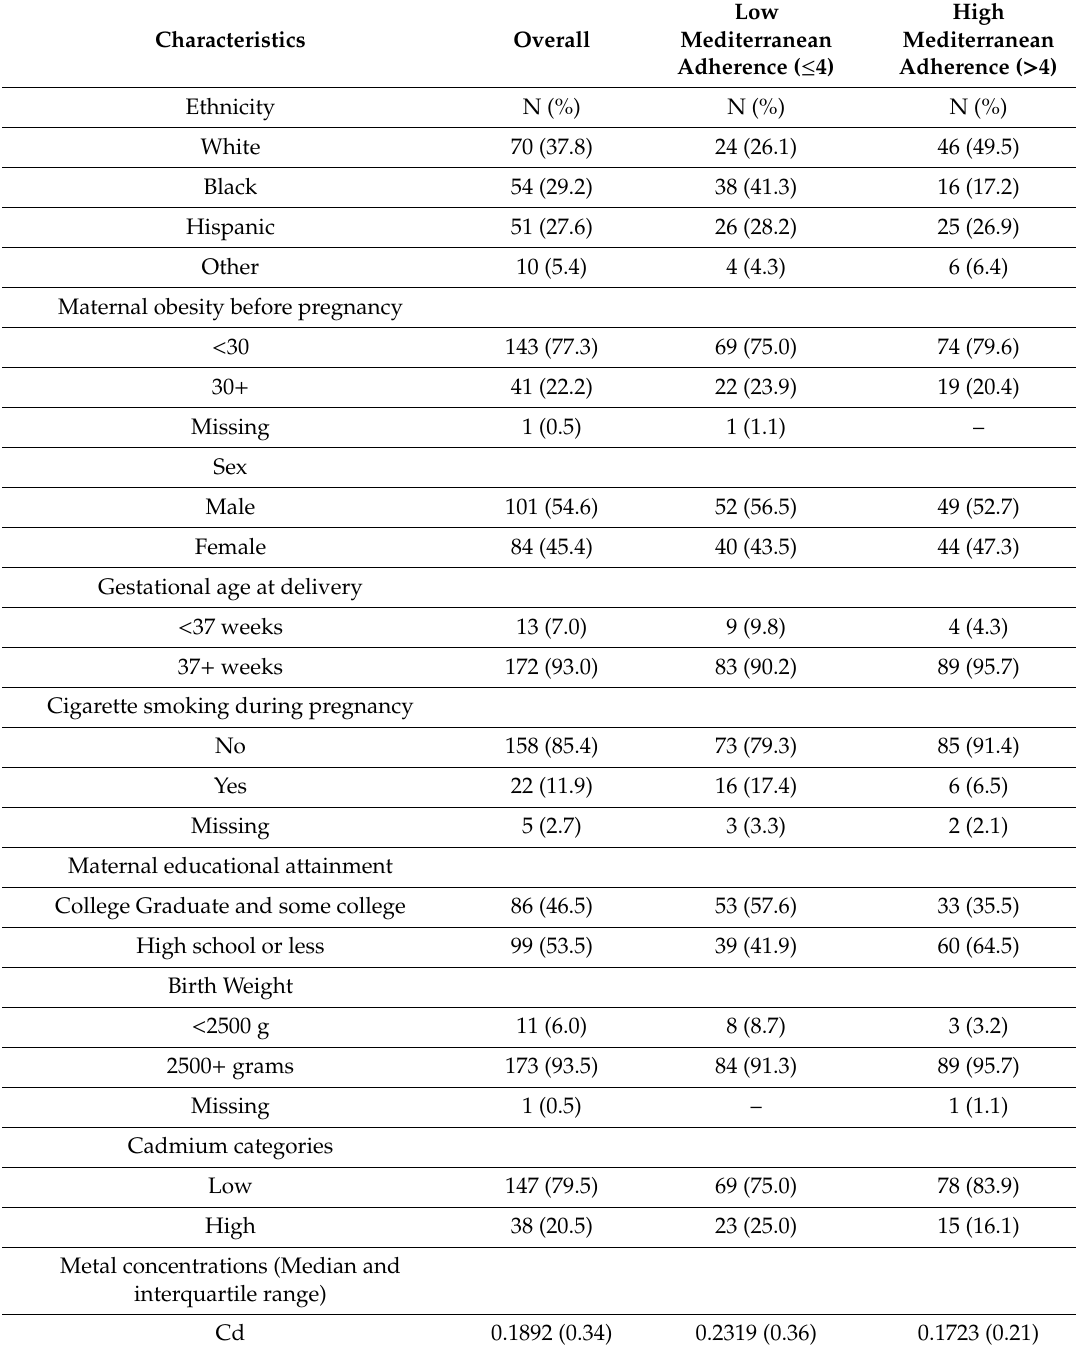
Table 2. Sociodemographic characteristics of study participants by Mediterranean diet